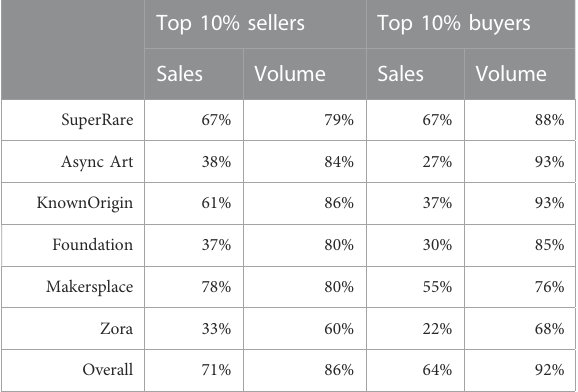
TABLE 2 Fraction of sales and volume (in USD) controlled by the top 10% sellers (columns 1 and 2), and by the top 10% buyers (columns 3 and